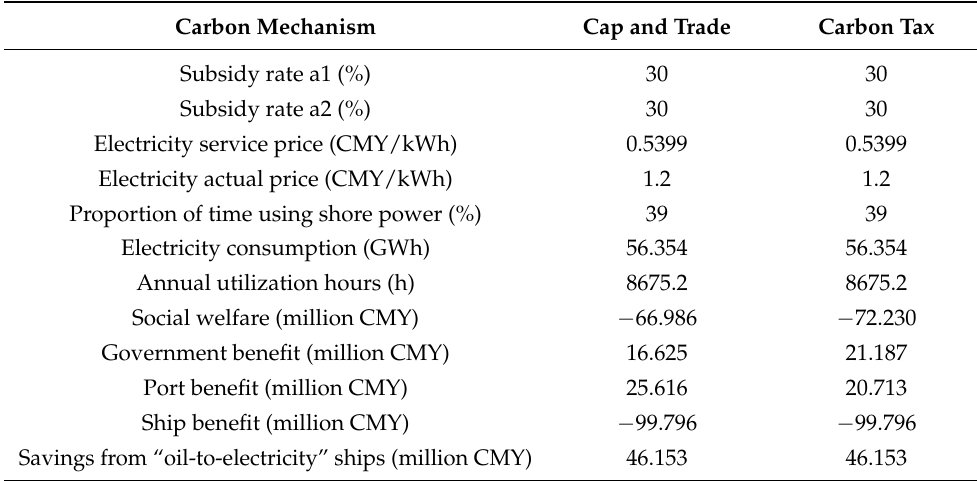
Table 6. Comparison of the impact of time-proportional on economic benefits to all parties under the two carbon regimes.